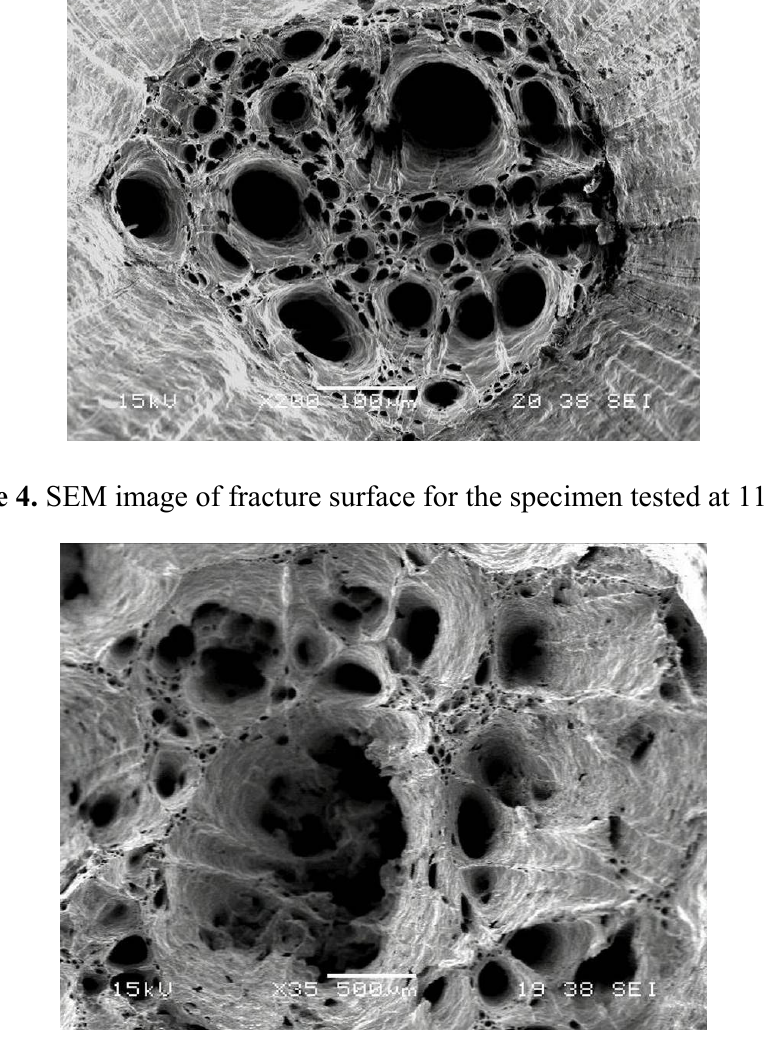
Figure 5. SEM image of fracture surface for the specimen tested at 1050 °C.